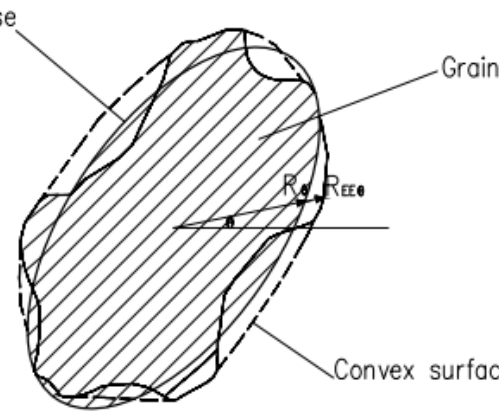
Figure 1. Schematic diagram of the particle equivalent ellipse and convex surface.